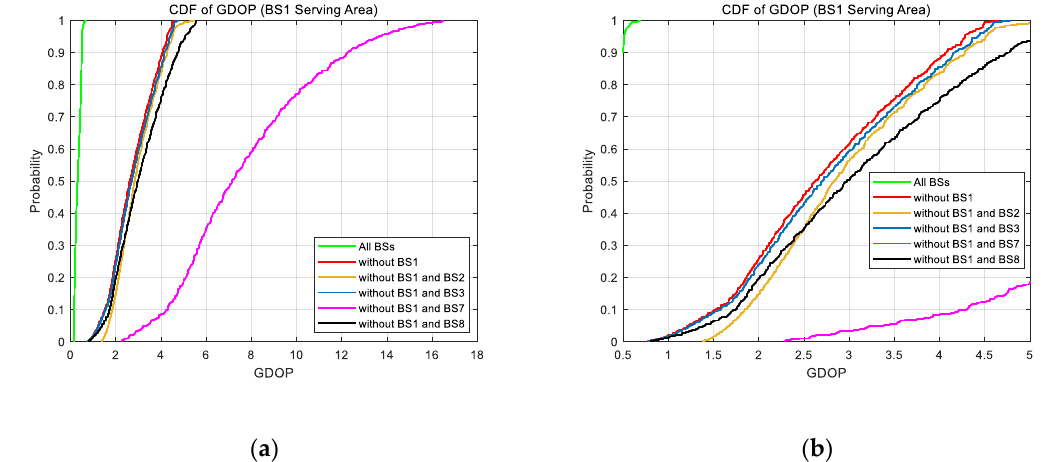
Figure 9. The cumulative distribution functions (CDFs) of GDOP value in BS 1 serving area with different BS selection combinations. ( a ) The overall CDF curves; ( b ) enlarged view of CDF curves when GDOP is 0.5 to 5 in ( a ).